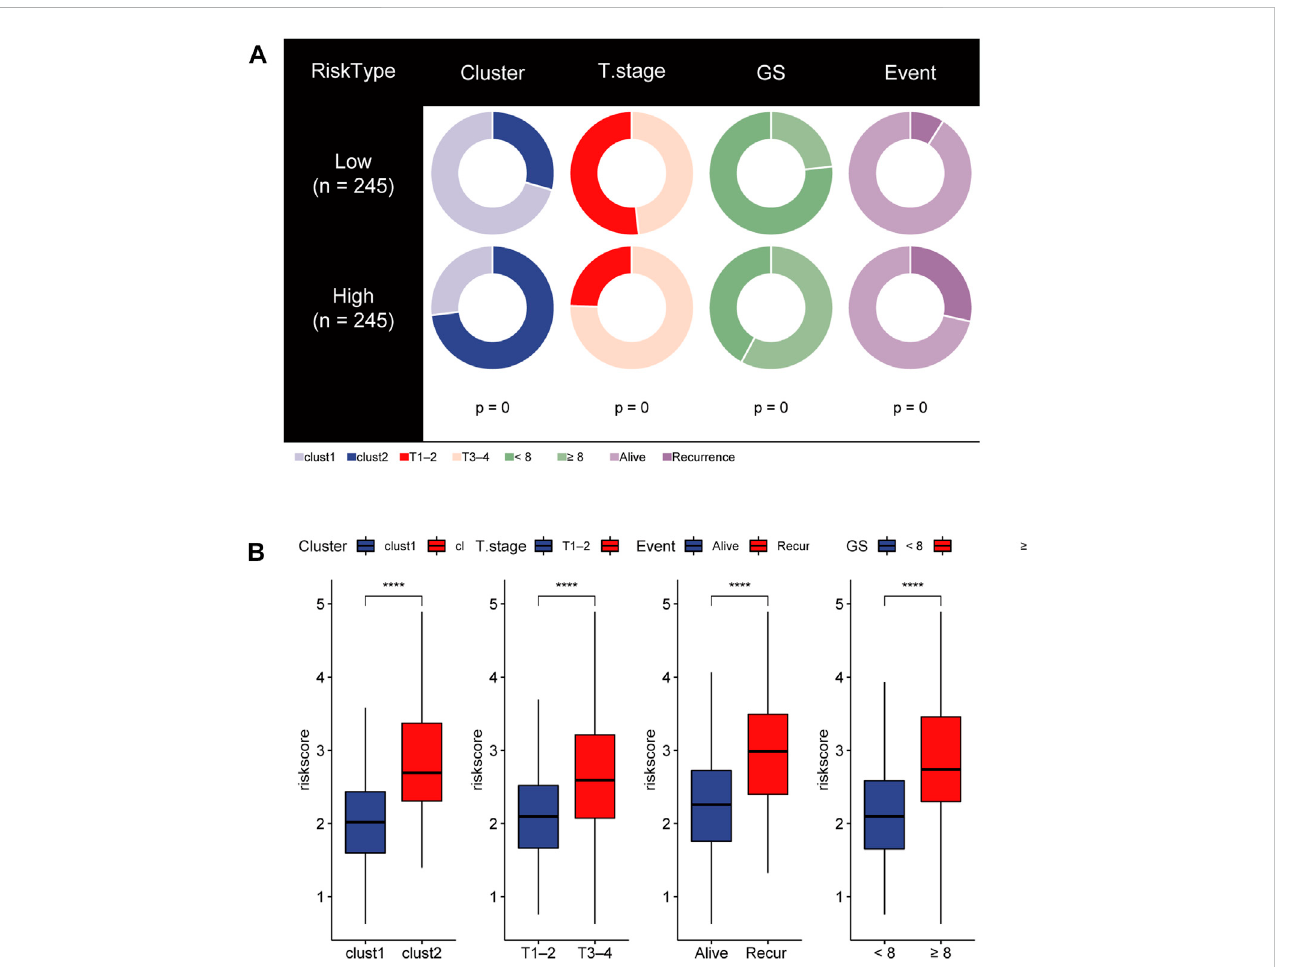
FIGURE 8 (A) Strati fi edproportionofclinicalfeaturesofPCapatientsintheHRgroupandLRgroup. (B) AssociationoftheriskscorewithCRGs-relatedsubtypeand clinical characteristics including T stage, recurrence status and